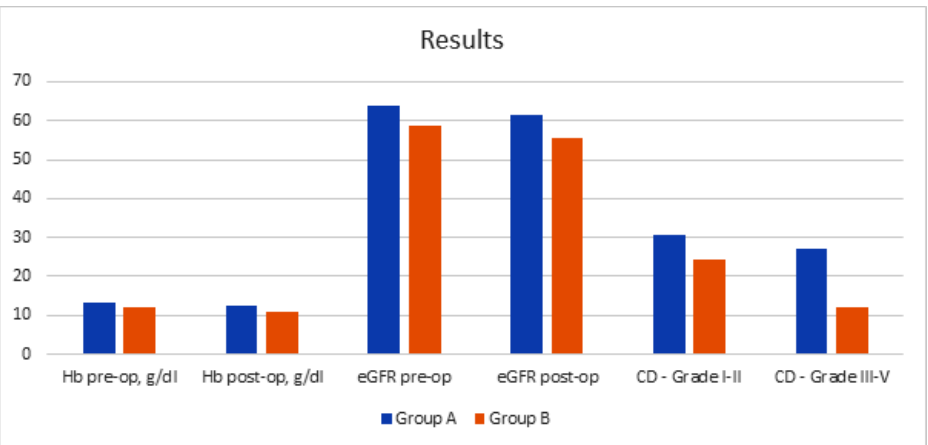
Figure 1. Intraoperative and postoperative results. Hb: Hemoglobin; eGFR: Estimated Glomerular Filtration Rate.